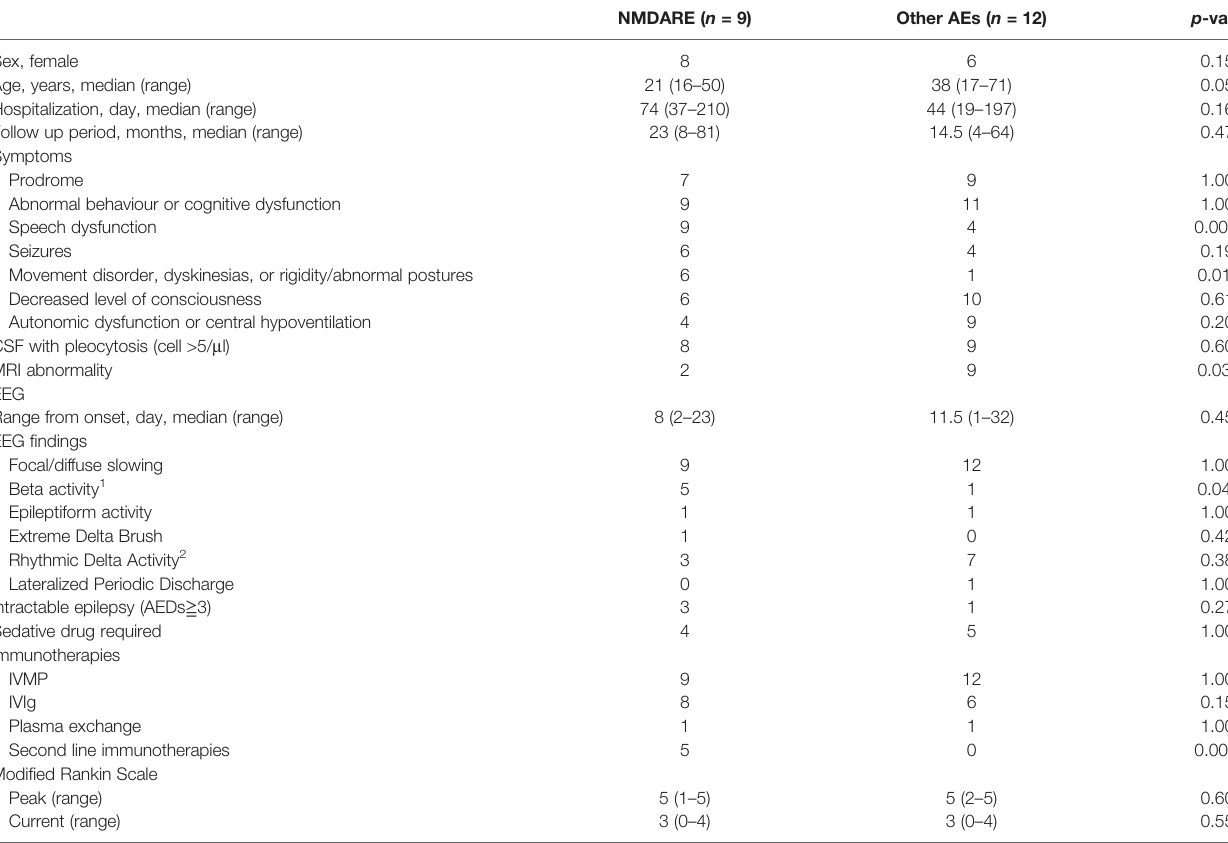
TABLE 1 | Comparison of the clinical features between NMDARE and other